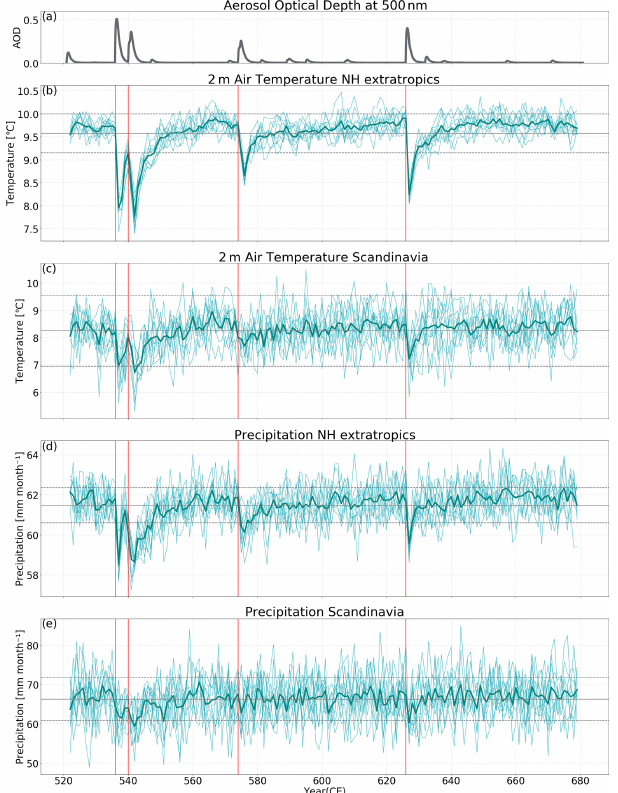
Figure 2. Time series of (a) yearly mean NH extratropical (30– 90 ◦ N) AOD (Toohey and Sigl, 2017), growing season (AMJJAS) mean of (b) NH extratropical and (c) Scandinavian (55–73 ◦ N, 0– 20 ◦ E) 2m air temperature, and (d) NH extratropical and (e) Scandi- navian precipitation. Vertical red lines indicate the four large erup- tions in the study period. Grey lines indicate the 1–1850CE mean, and the dashed lines are the 1 σ (2 σ ) of the control run for precipi- tation (temperature).